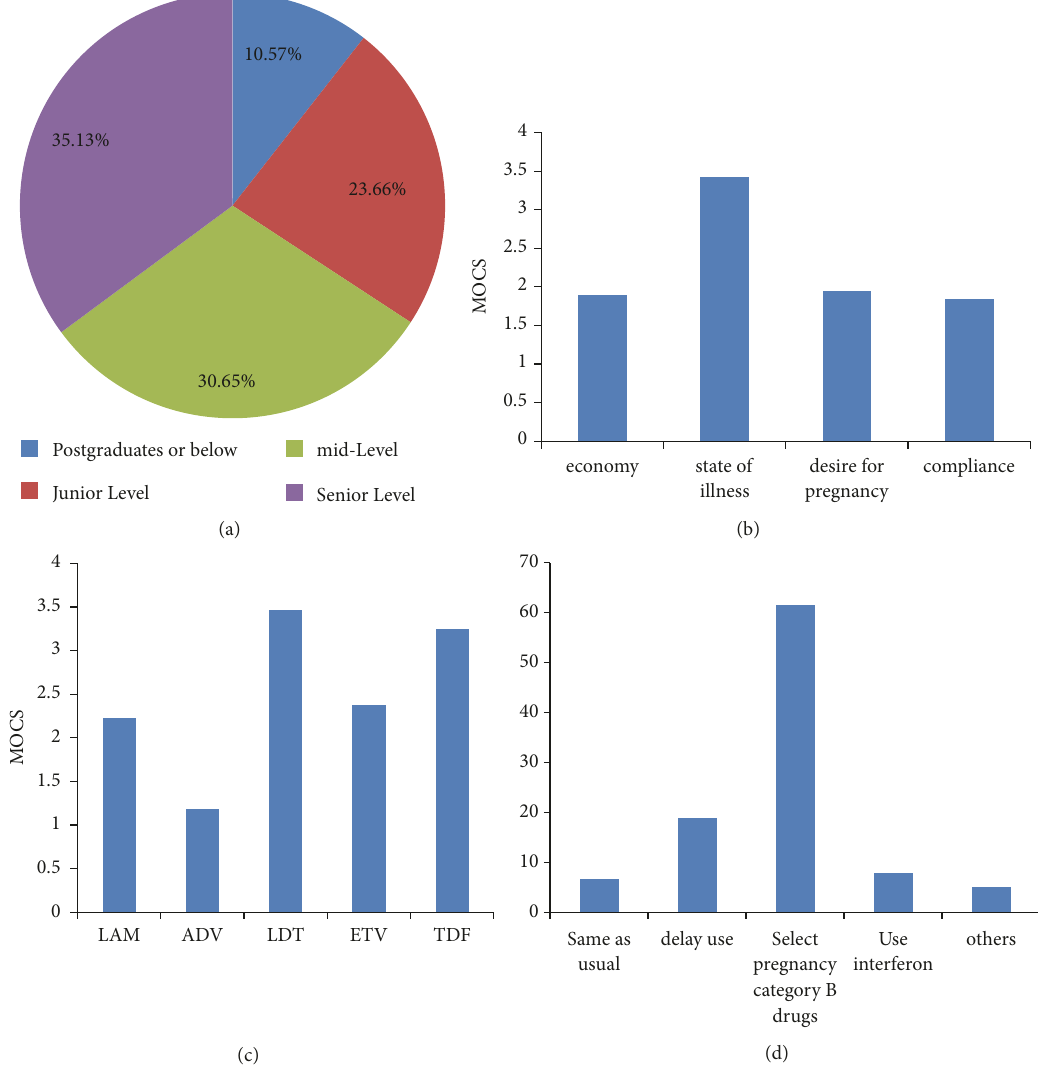
Figure 5: Consideration analysis of drug choice for child-bearing age male patients by doctors. (a) Professional composition of liver disease specialists who participated in questionnaire survey. (b) Considerations for setting a plan for male patients who met criteria for antiviral therapy. (c) Treatment selection for male patients who desired pregnancy in the near future. (d) Proportion of doctors with different recommendations for male patients who met criteria for antiviral therapy and desire future pregnancy. MOCS: mean options comprehensive